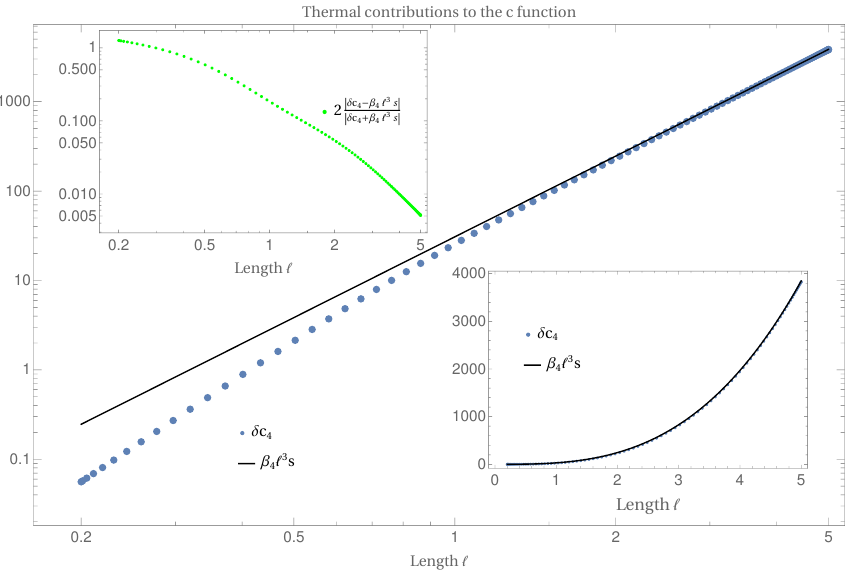
Figure 14 . The deviation δc 4 of the thermal c-function, evaluated in the thermal state dual to the AdS Schwarzschild black brane, from the central charge a 4 , displayed as the blue points. The thermal subtraction β 4 ‘ 3 s is displayed as a black line. Its behavior precisely matches δc 4 in the IR. The bottom right inset graphic displays the same information only not in a log-log scale, the top left inset displays the difference as green points on a log-log